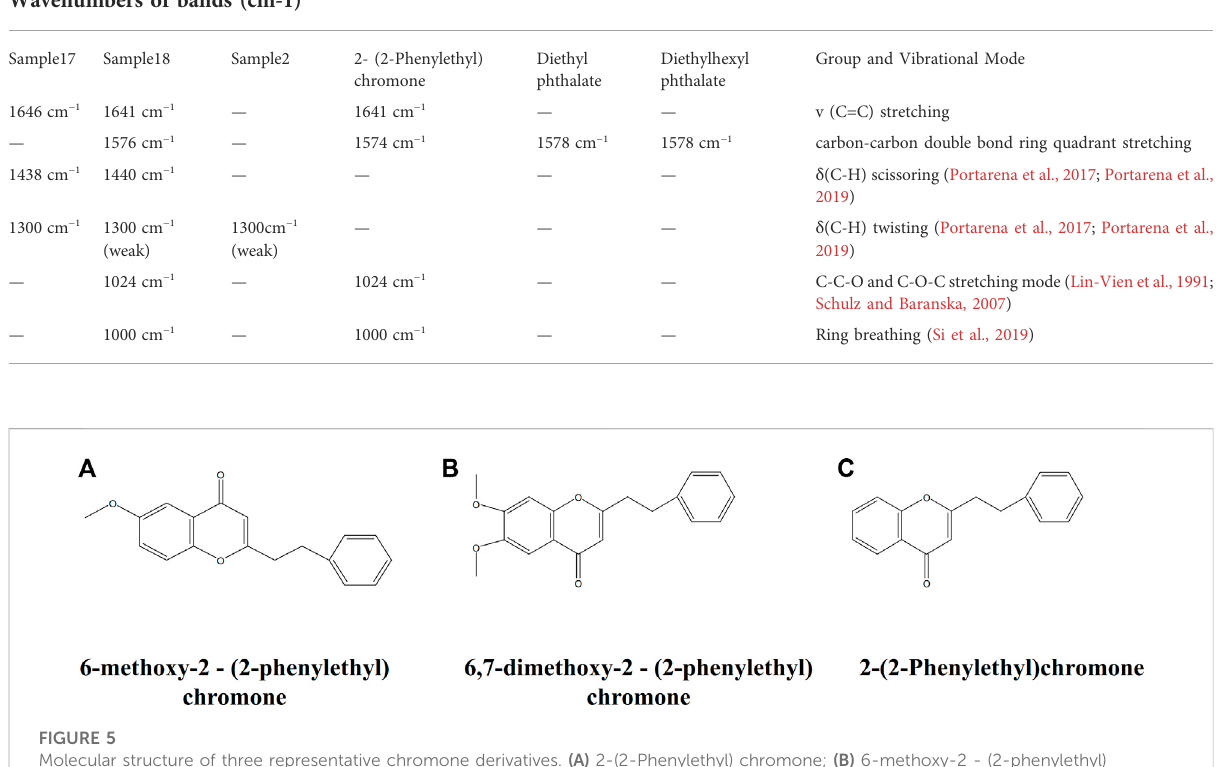
TABLE 3 The characteristic bands (cm − 1 ) and assignment in the Raman spectra of the AEOs and their comparison with the Raman characteristics of standards and adulterants. Wavenumbers of bands (cm-1)